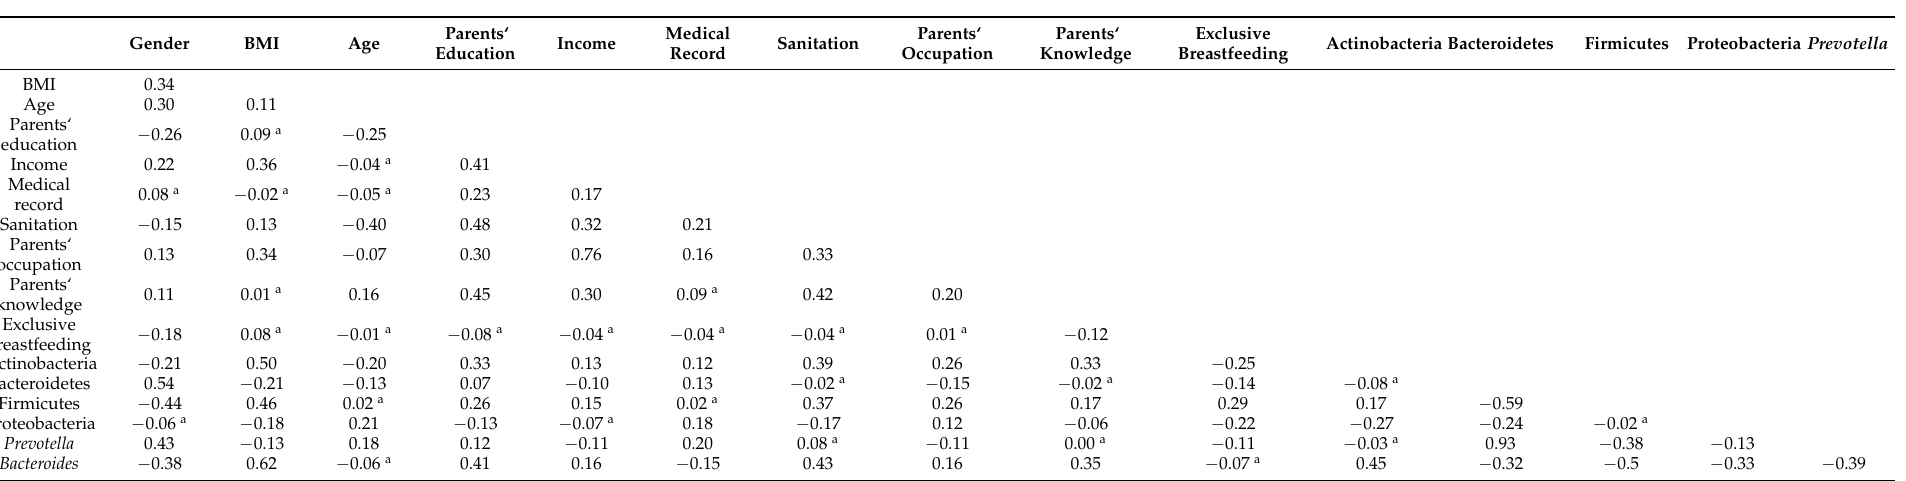
Table 5. Correlation between sociodemographic factors and gut microbiota composition in undernourished